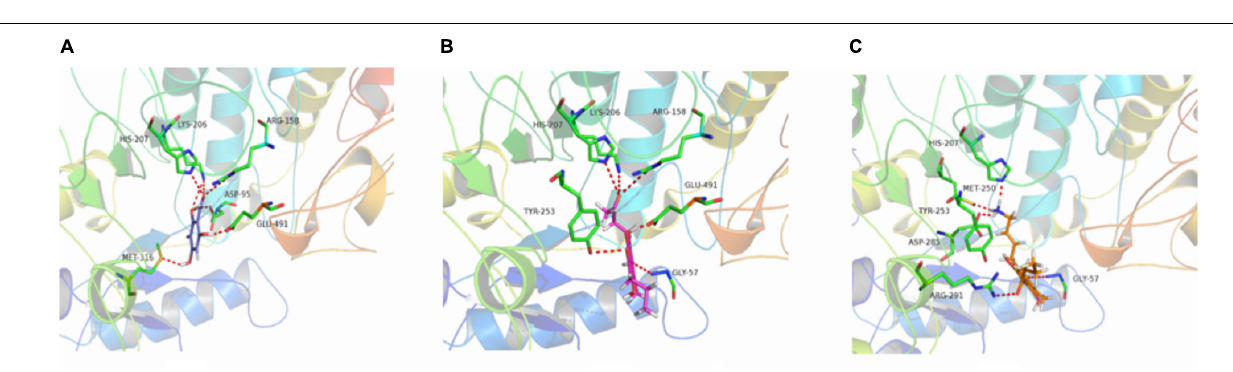
FIGURE 8 | 3D docking conformation of compounds with 1LQ2: (A) 3D docking conformation of compound b with 1LQ2; (B) 3D docking conformation of compound e with 1LQ2; (C) 3D docking conformation of compound g with